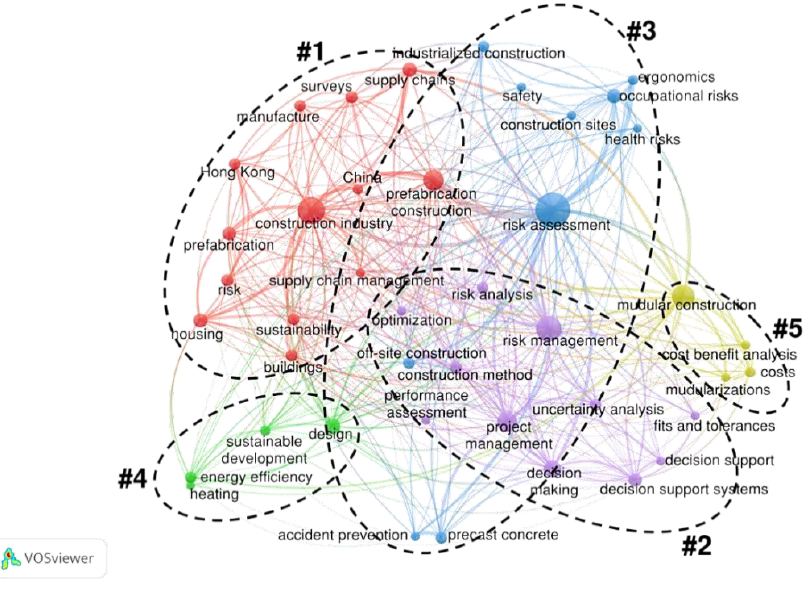
Figure 5. Keyword co-occurrence